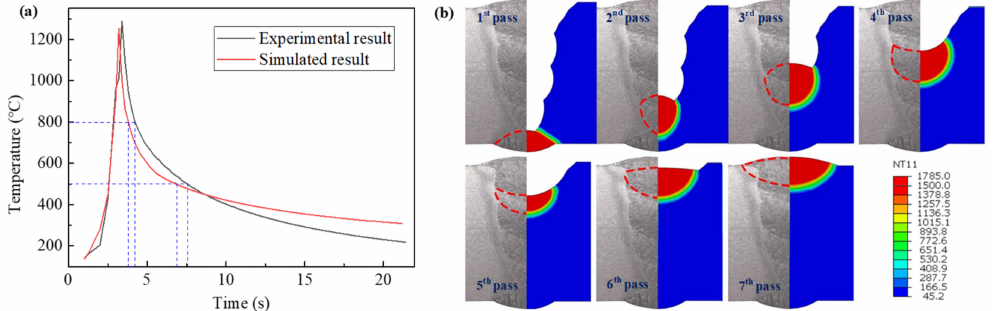
Figure 11. Comparison between simulation results and ( a ) thermal cycle measurement, ( b ) weld joint